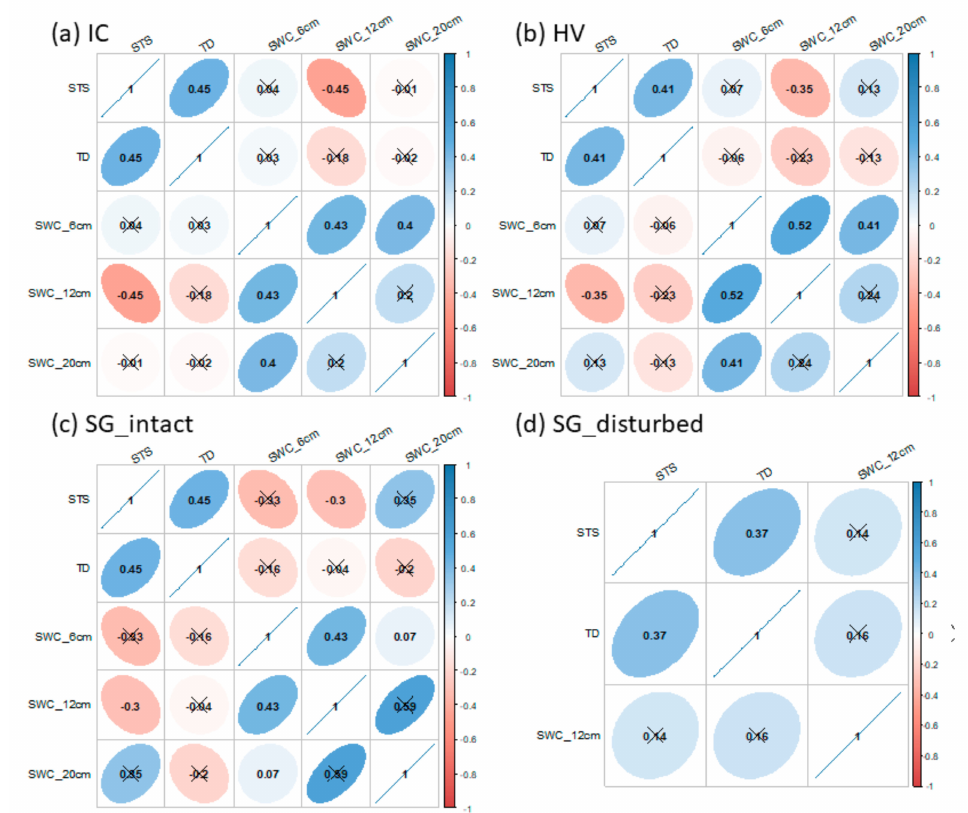
Figure 9. Correlation matrix among STS (seasonal thaw settlement), TD (maximum thaw depth), TDR period (travel time of electromagnetic waves) at 6 cm depth (SWC_6cm), TDR period at 12 cm depth (SWC_12cm), and TDR period at 20 cm depth (SWC_20cm) for sites ( a ) IC, ( b ) HV, ( c ) SG_intact, and ( d ) SG_disturbed. The color bars and figures in the matrix indicate the Pearson’s correlation coefficient. The correlation coefficients with p -value > 0.001 are crossed